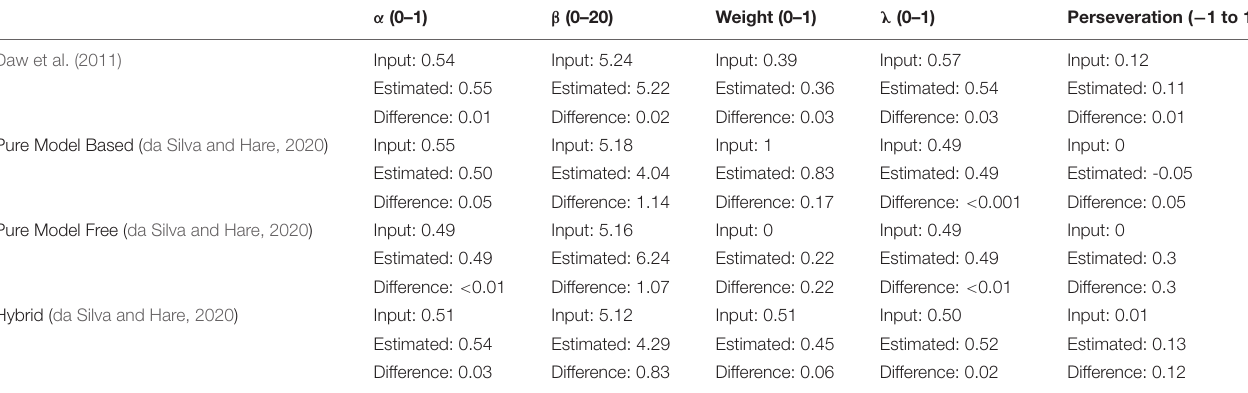
TABLE 2 | Generated (input) and estimated parameters for simulations.